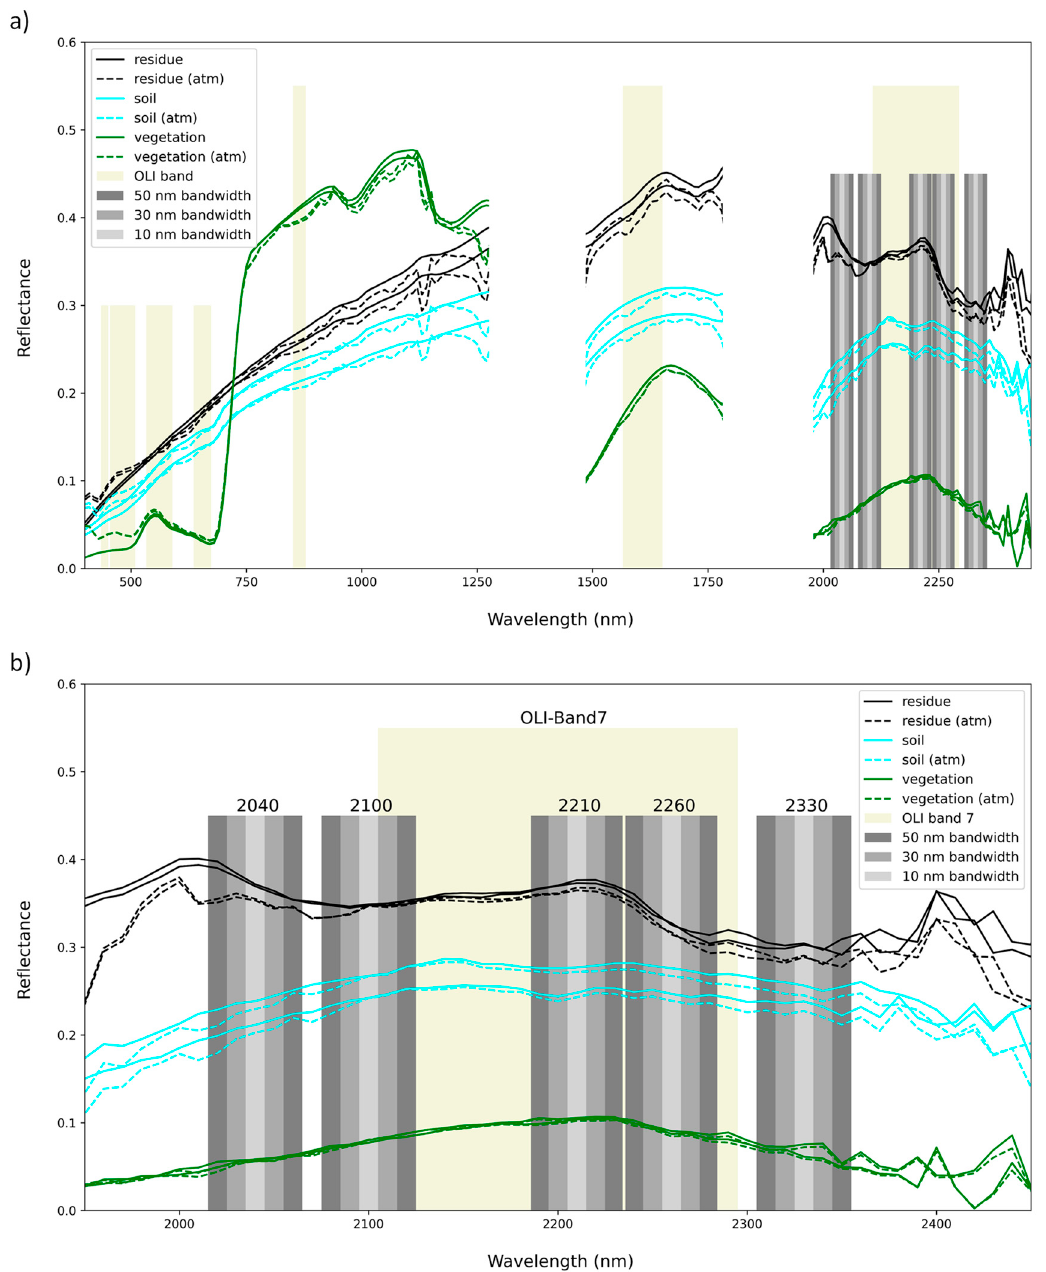
Figure 1. Example spectra for crop residue (NPV), soil, and green vegetation as surface reflectance and as surface reflectance with addition of simulated sensor noise and atmospheric correction residuals (atm) for ( a ) 400–2500 nm wavelength range, and ( b ) 1950–2450 nm wavelength range for the same spectra, showing the five shortwave infrared (SWIR) bands under consideration at 10, 30, and 50 nm bandwidths (grey bars) as well as current Landsat Operational Land Imager (OLI) bands (tan bars). Note the decreased crop residue reflectance at 2100 nm and 2300 nm due to ligno-cellulose absorption, with bordering reflectance maxima at 2000 nm and 2210 nm. The five narrow SWIR bands under consideration capture these differences in spectral reflectance, which are otherwise convolved into a single Landsat 8 OLI Band 7.